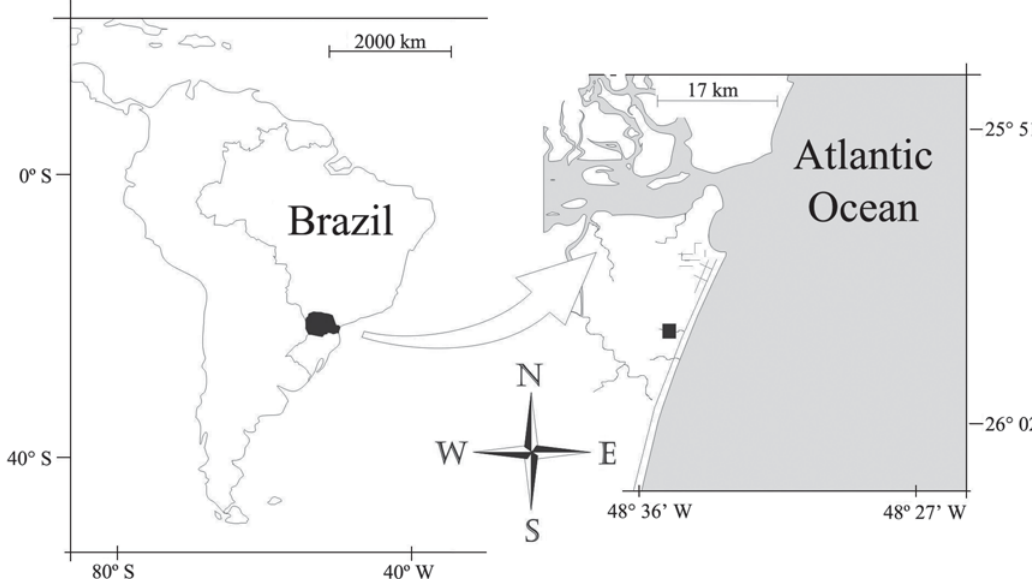
Fig. 1. Location of the study site in Guaratuba Munipality (black square), Paraná State coast (southern Brazil).